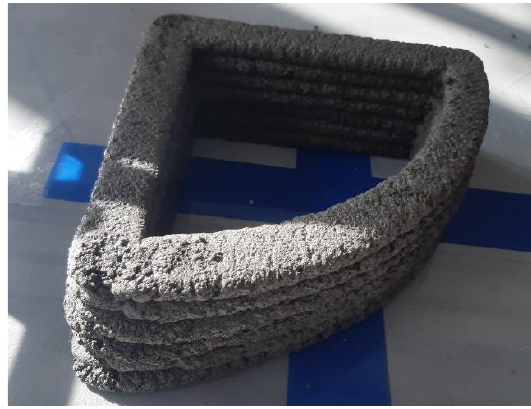
Figure 8. Mix A made with a 3D printer.